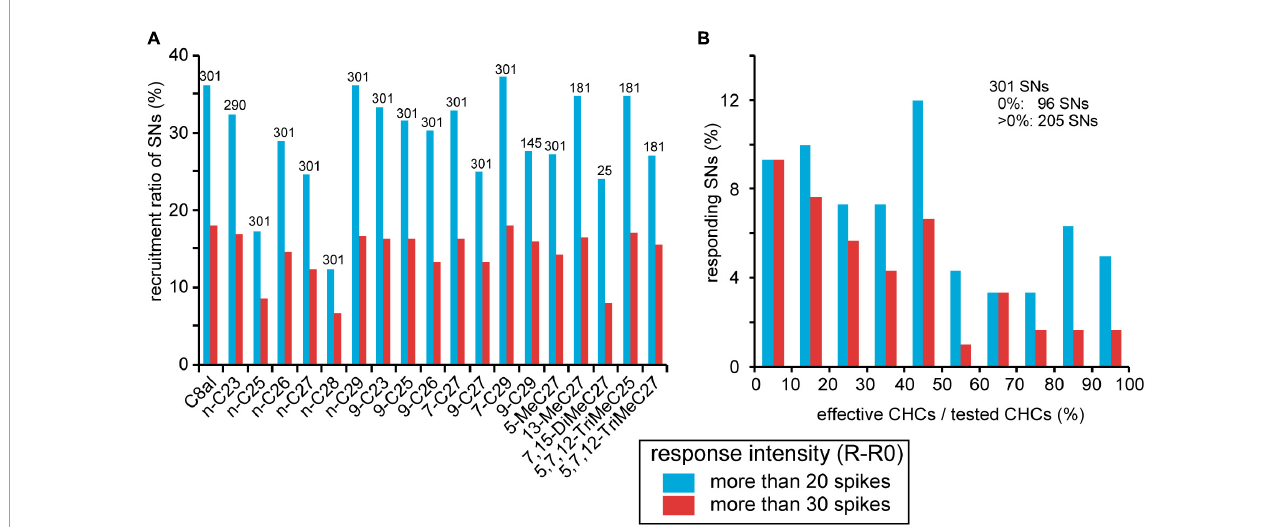
FIGURE5 Summary of responses of 301 sorted SNs to CHCs. (A) Recruitment rates of SNs. CHC responses of 301 SNs from 23 sensilla were evaluated according to an increase in spike frequency from the spontaneous level (R-R0; See section “Materials and methods”). When the value was > 20 spikes, we regarded the SN to be activated by the CHC. The percentages of activated SNs per CHC are shown as recruitment rates. Because it is not that all 301 sorted SNs were tested all 18 CHCs ( Table 2 ), numbers above bars show the numbers of sorted SNs that we successfully recorded the response to the given CHC. (B) CHC specificities of SNs. Among 301 sorted SNs, 205 exhibited excitatory responses (R-R0 > 20 spikes) to more than one CHC. In each sorted SN, we calculated the percentages of the number of effective CHCs per that the number of tested CHCs as CHC specificity. Distribution of CHC specificities of 301 sorted CHCs is shown as a histogram. The percentage of SNs that did not respond to any tested CHC is omitted from the histogram. In both panels (A,B) , the response intensity of each SN to a given CHC is represented by two levels of response intensity (R-R0 > 20, blue bars, R-R0 > 30, red